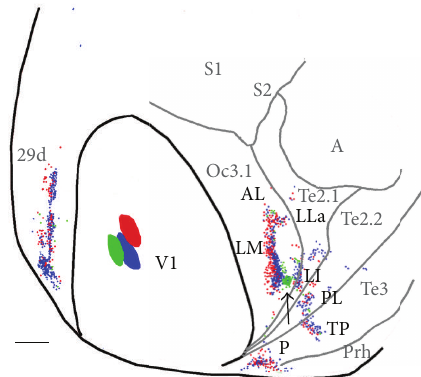
Figure 6: Labeling pattern produced by three closely spaced injections of RB, GB, and FB (case 86-6). A mirror-image reversal of the RB-FB-GB labeling sequence (arrow) suggests the location of the LM/LI border. Medial is to the left and posterior is down. TP: temporal posterior area. Scale bar 2 =